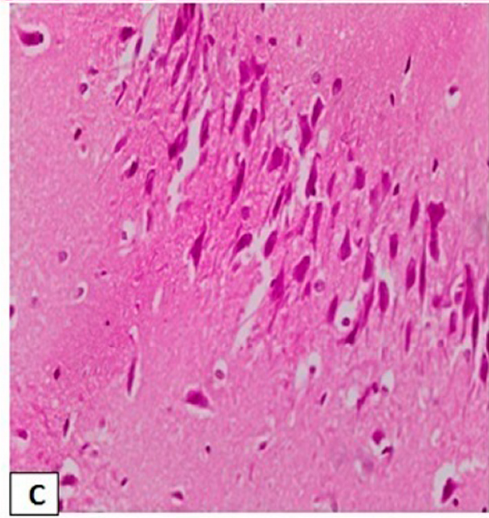
Figure 3. Histopathological examination of the CA3 region in hippocampus. Normal morphology for cells and adequate number in CA3 in brains obtained from the Sal group ( A , H&E, 400×), reduced number of neurons with pyknotic changes (black arrows) in neurons of CA3 in brains obtained from the Sal + PTZ group ( B , H&E, 400×) and significant number of neurons with normal morphology in CA3 in brains obtained from the L -Car + PTZ group ( C , H&E, 400×).